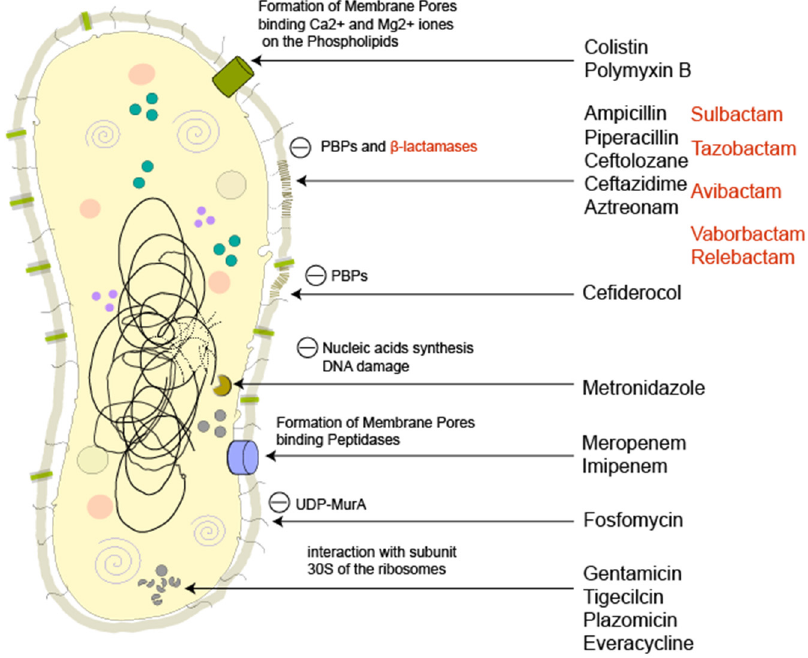
Figure 6. Illustration of a Gram-negative bacteria and the site of action of all the antimicrobial molecules cited in this comprehensive review. The figure is an original production by S. Di Franco and A. Alfieri. Notes — PBPs: penicillin-binding proteins; UDP-MurA: UDP-N-acetylmuramic acid.